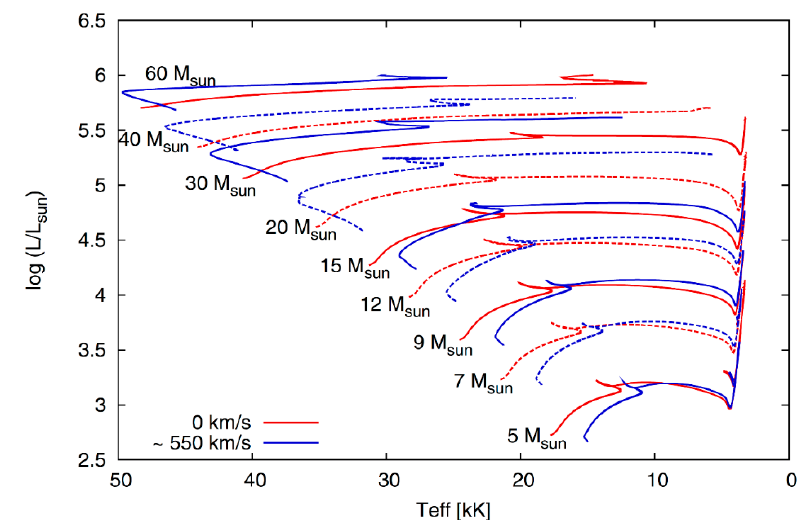
Figure 14. Comparison of evolution models at solar metallicity with rotation velocities on the zero-age main-sequence of 0 and 550 km s − 1 . The velocities may be higher than actually observed in stars but were chosen to illustrate the effect of rotation on the evolutionary tracks. From [62].